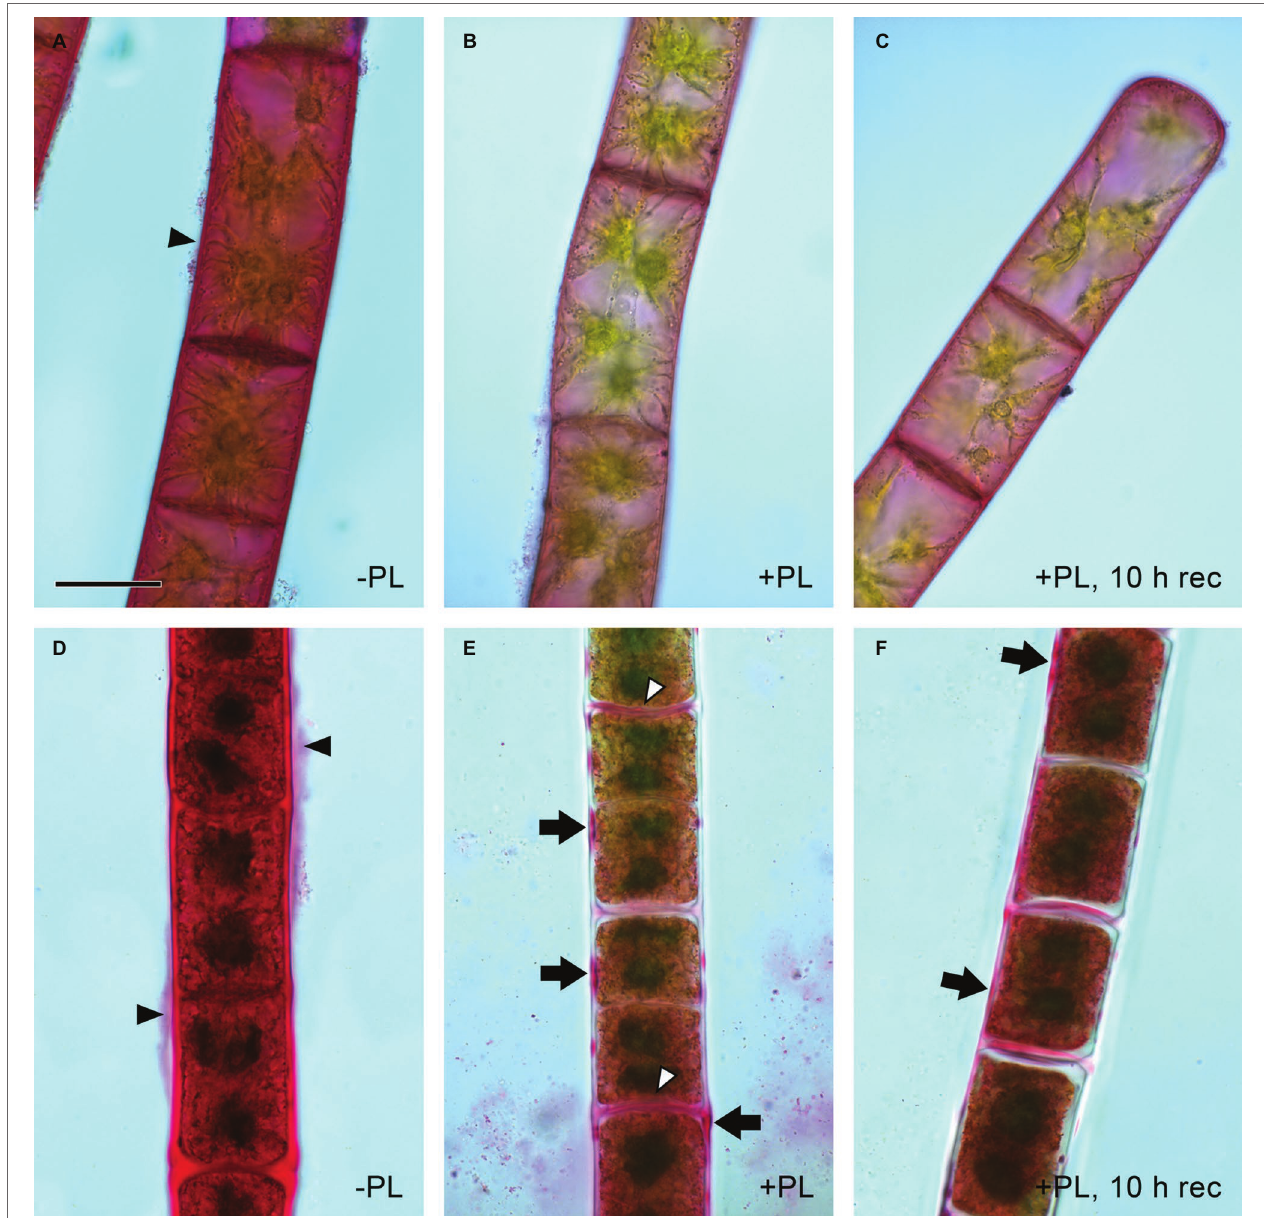
FIGURE 2 | Detection of pectin by ruthenium red staining. Young (A–C) and old (D,E) filaments. (A,D) No pectate lyase treatment, (B,E) PL treatment and (C,F) PL treatment followed by 10 h recovery. (A,D) Red staining in cell walls and pectic sheath layer (arrowheads), (E) patchy staining in outer cell walls (arrows) and throughout most cross cell walls (arrowheads), (F) patchy staining in (E) replaced by more continuous staining (arrows). Scale bar = 20